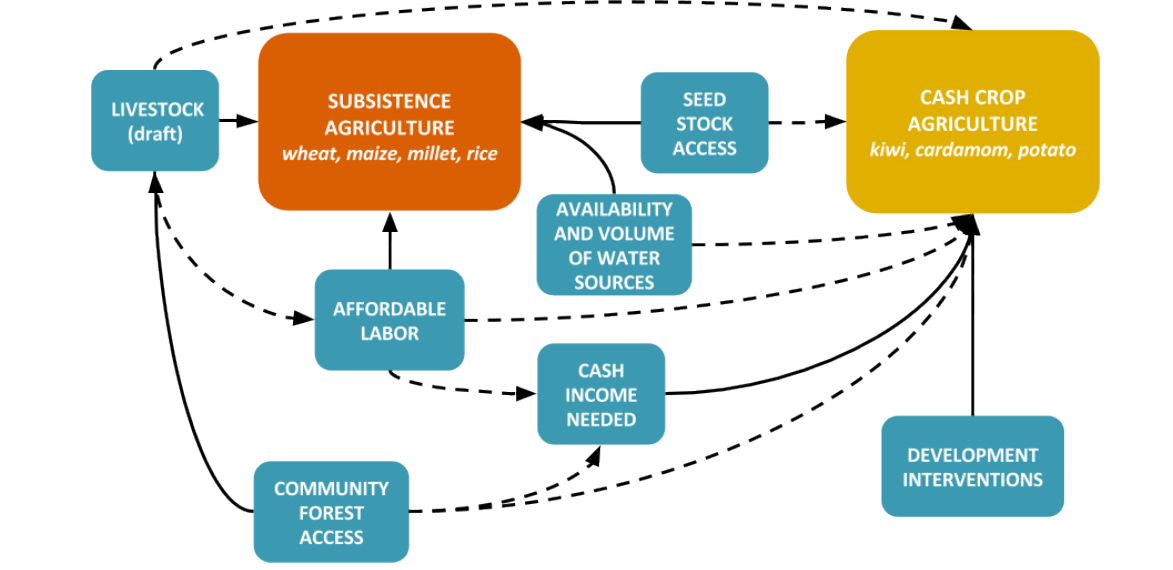
Fig. 5 . Schematic showing relationships between inputs, outputs, and the direction of impacts among those in subsistence and cash crop production in mid-montane Nepal. Solid arrows represent potentially positive feedbacks; dotted arrows represent potentially negative feedbacks. For example, increased access to forest resources enables more livestock because fodder is plentiful; it also implies lower need for cash because some inputs do not have to be purchased. The overall structure of the framework demonstrates pathways through which inputs to the Nepali farm system support the subsistence practices over the adoption of cash crops, or vice versa. The directions of the arrows are specific to our